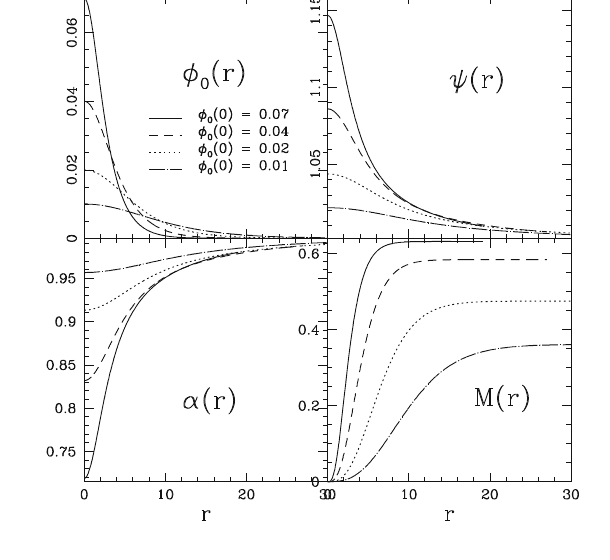
Fig. 2 Pro fi les characterizing static, spherically symmetric boson stars with a few different values of the central scalar fi eld (top left). Reproduced with permission from Lai